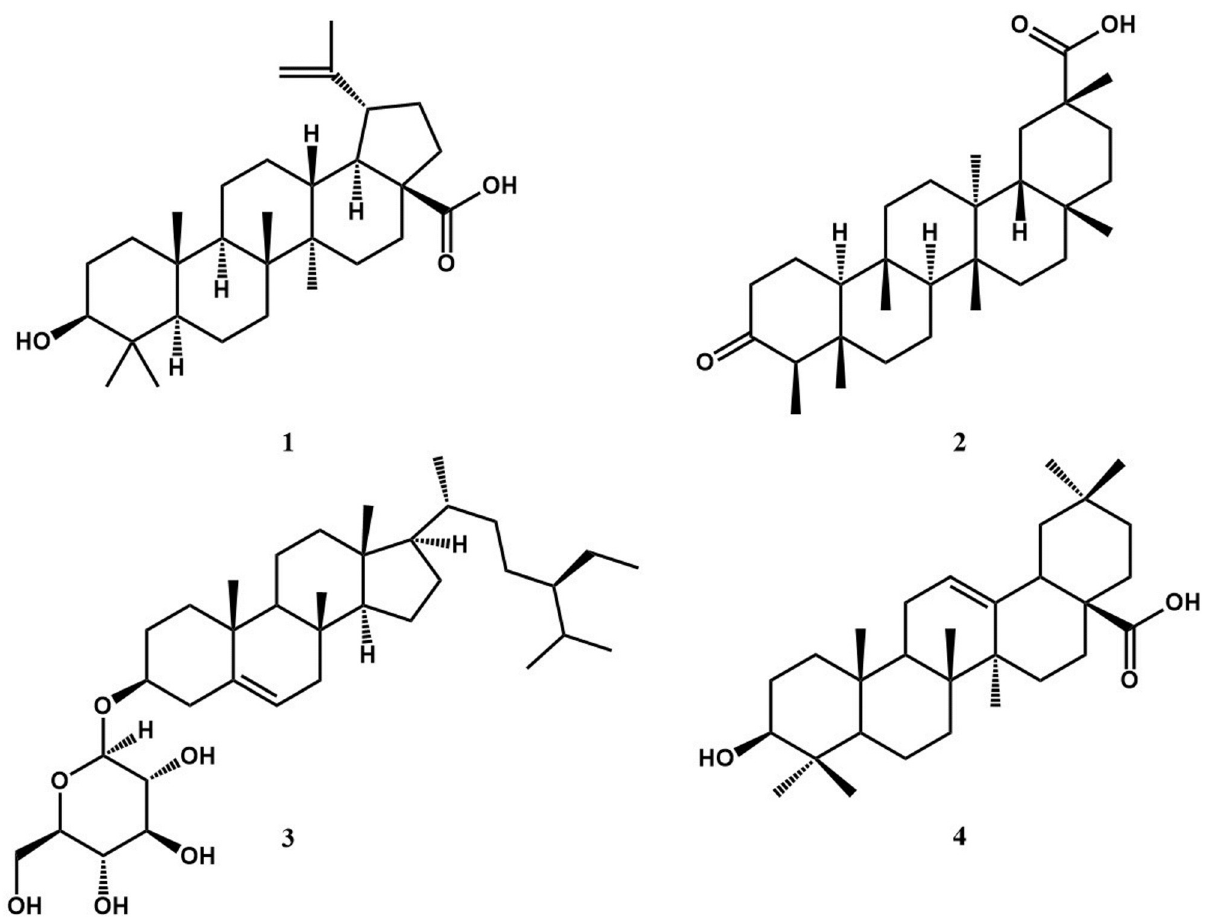
Fig 1. Structures of compounds isolated from the fruits of S . torvum .